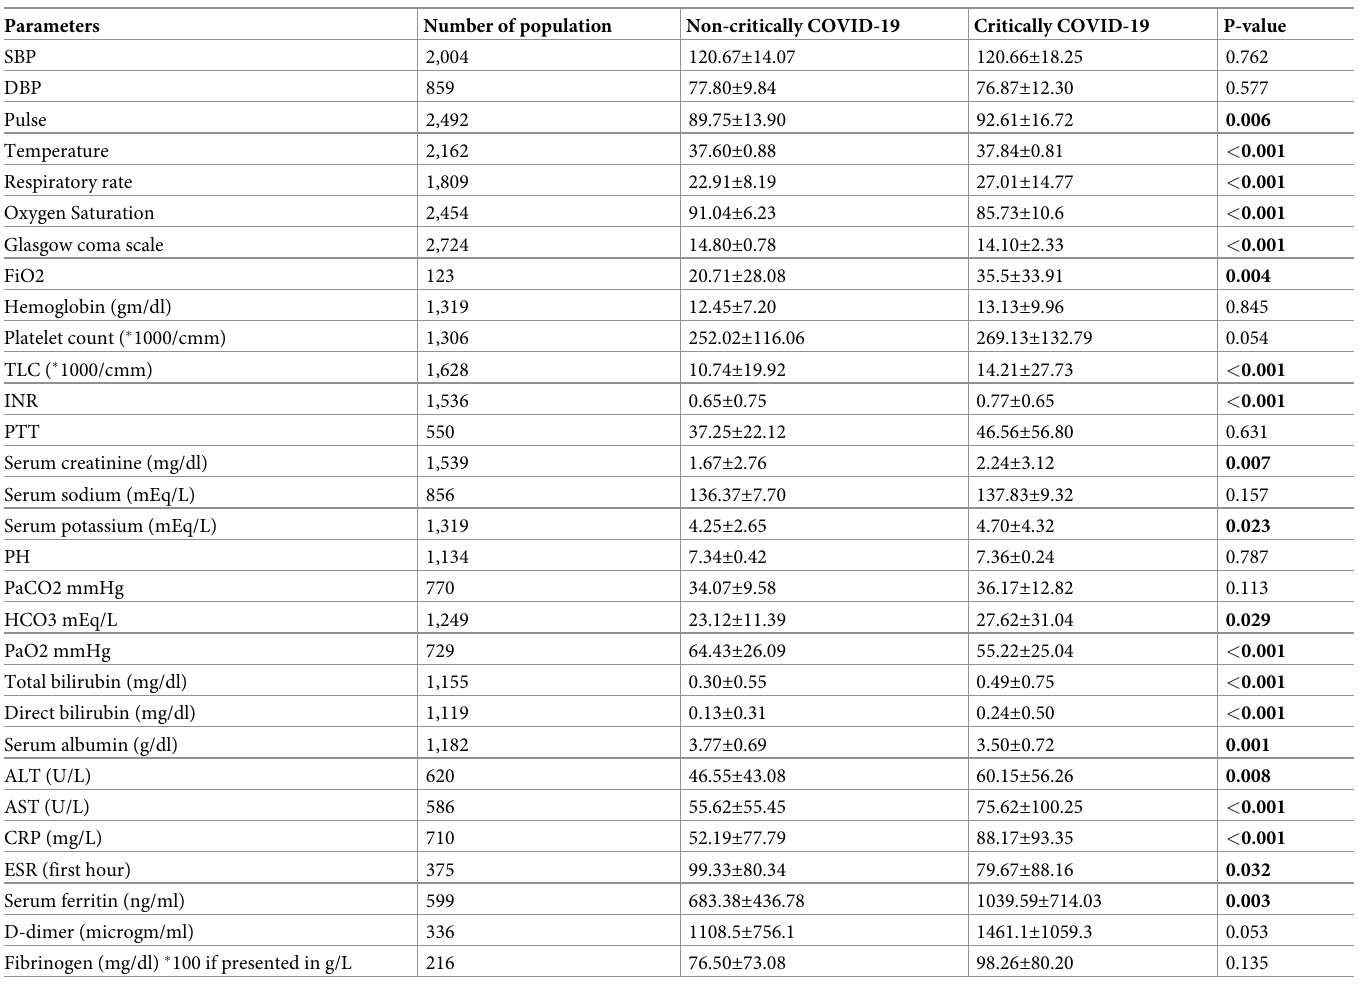
Table 2. Clinical and Laboratory characteristics of the included